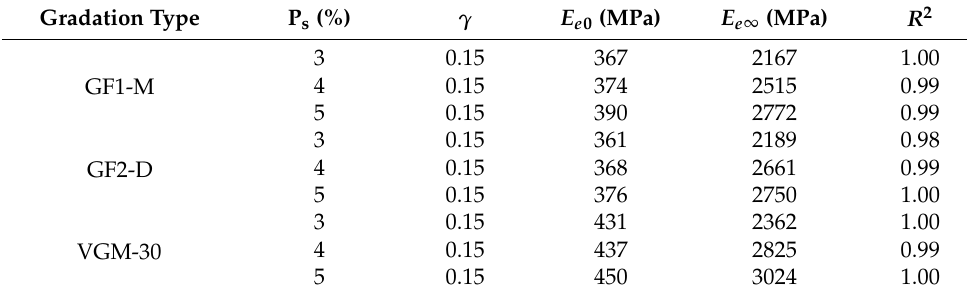
Table 11. Fitting regression coefficients of E eT /E e ∞ ~ T. Gradation Type